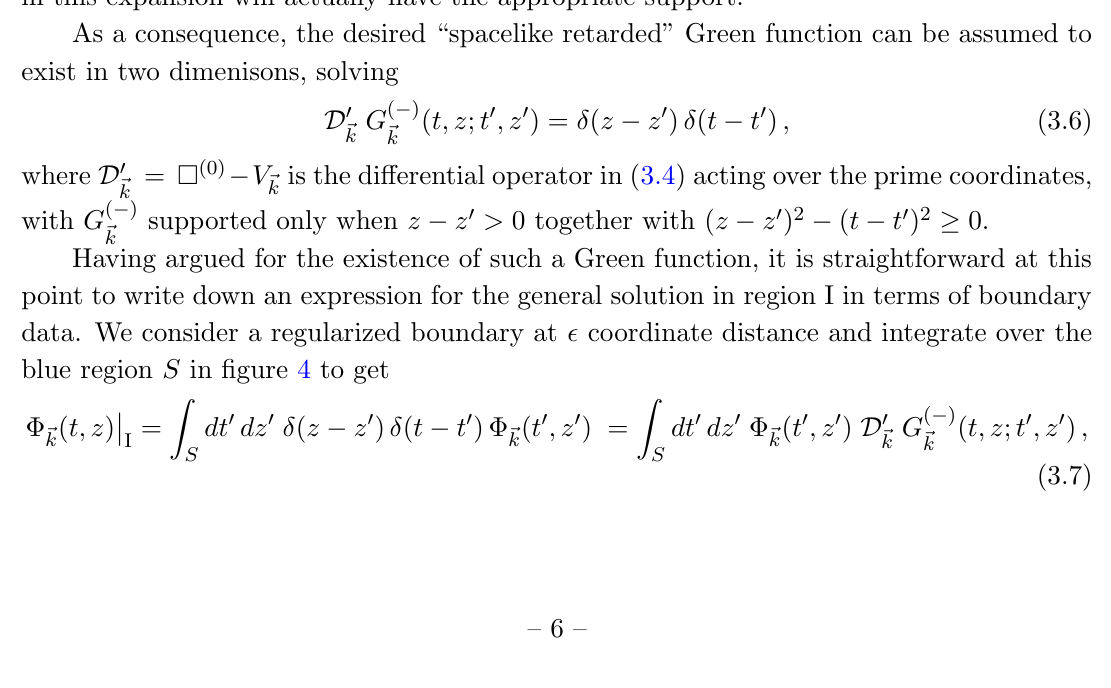
Figure 4 . The support of the Green function G ( − ) intersection with the (cid:30) -regularized boundary. The blue volume S is conveniently taken to apply Gauss’ law to the point in